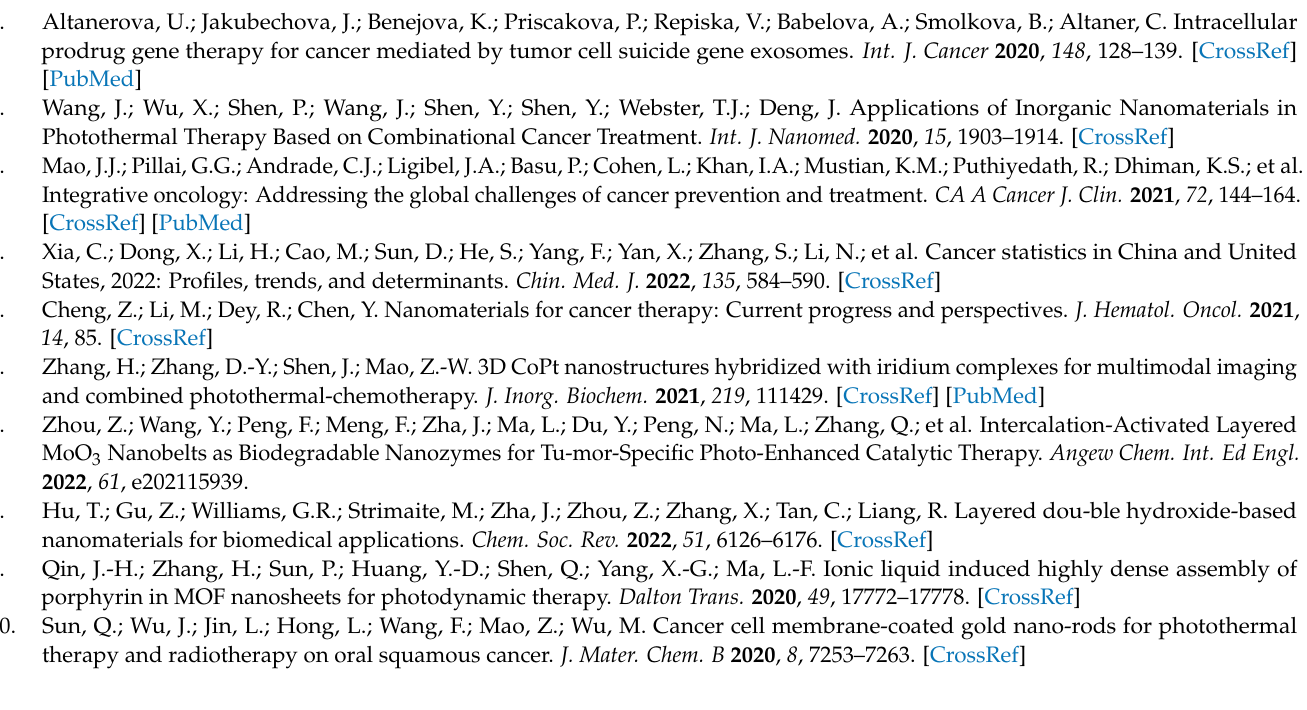
Figure S5: H&E-stained images of major organs of tumor-bearing mice after the various treatments. Figure S6: The weight of the tumor-bearing mice during the treatment